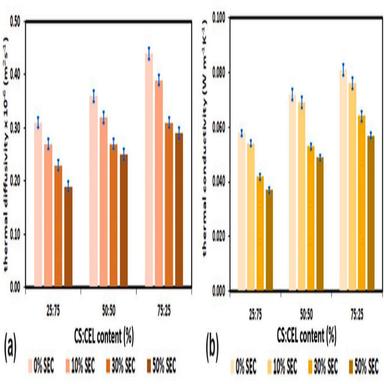
Graphical representation of (a) thermal diffusivity and (b) thermal conductivity presented in Table 3.